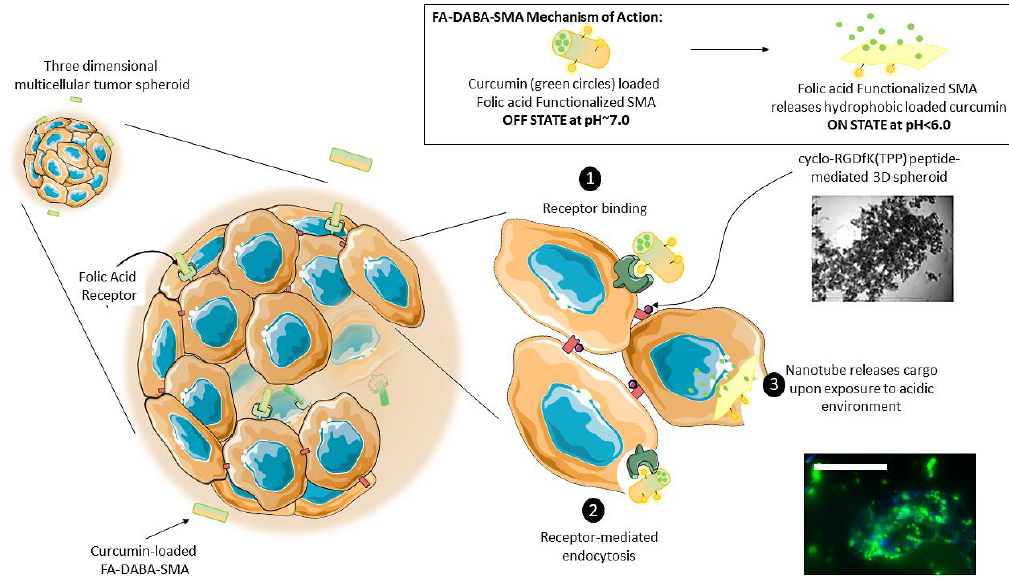
Figure 10. The proposed mechanism of nanoparticle transport and penetration through 3D tumour spheroid mass. FA-SMA loaded curcumin nanoparticles are transported through tumour spheroid mass by free diffusion in extracellular space. Some nanoparticles can involve cell binding to folic acid receptors and go through cell internalization or change their conformation into individual chains thereby effectively releasing their cargo. This schematic illustrates a pH-responsive, “smart” active polymeric delivery system using folate functionalized amphiphilic alternating copolymer poly(styrene-alt-maleic anhydride) (FA-DABA-SMA) via a biodegradable linker 2,4-diaminobutyric acid (DABA). The “off state” occurs at a neutral pH when the polymer self-assembles into an ordered nanotube conformation (as depicted in the top right panel) and is capable of encapsulating a hydrophobic agent, such as curcumin as pictured above. In an acidic tumour microenvironment, these nanotubes change their conformation into individual chains thereby effectively releasing their cargo. These curcumin loaded nanotubes are proposed to interact with 3D tumour spheroids through FA-DABA-SMA binding to the overexpressed folic acid receptors on pancreatic cancer cells (1) and are internalized through receptor-mediated endocytosis (2). The hydrophobic drug is then released intracellularly (3). While the cancer cells adhere to each other to generate a spheroid, the nanotubes containing curcumin are capable of penetrating the inner of a spheroid and delivering the therapeutic agent as shown in the fluorescence image. Scale bar represents 100 µ m.